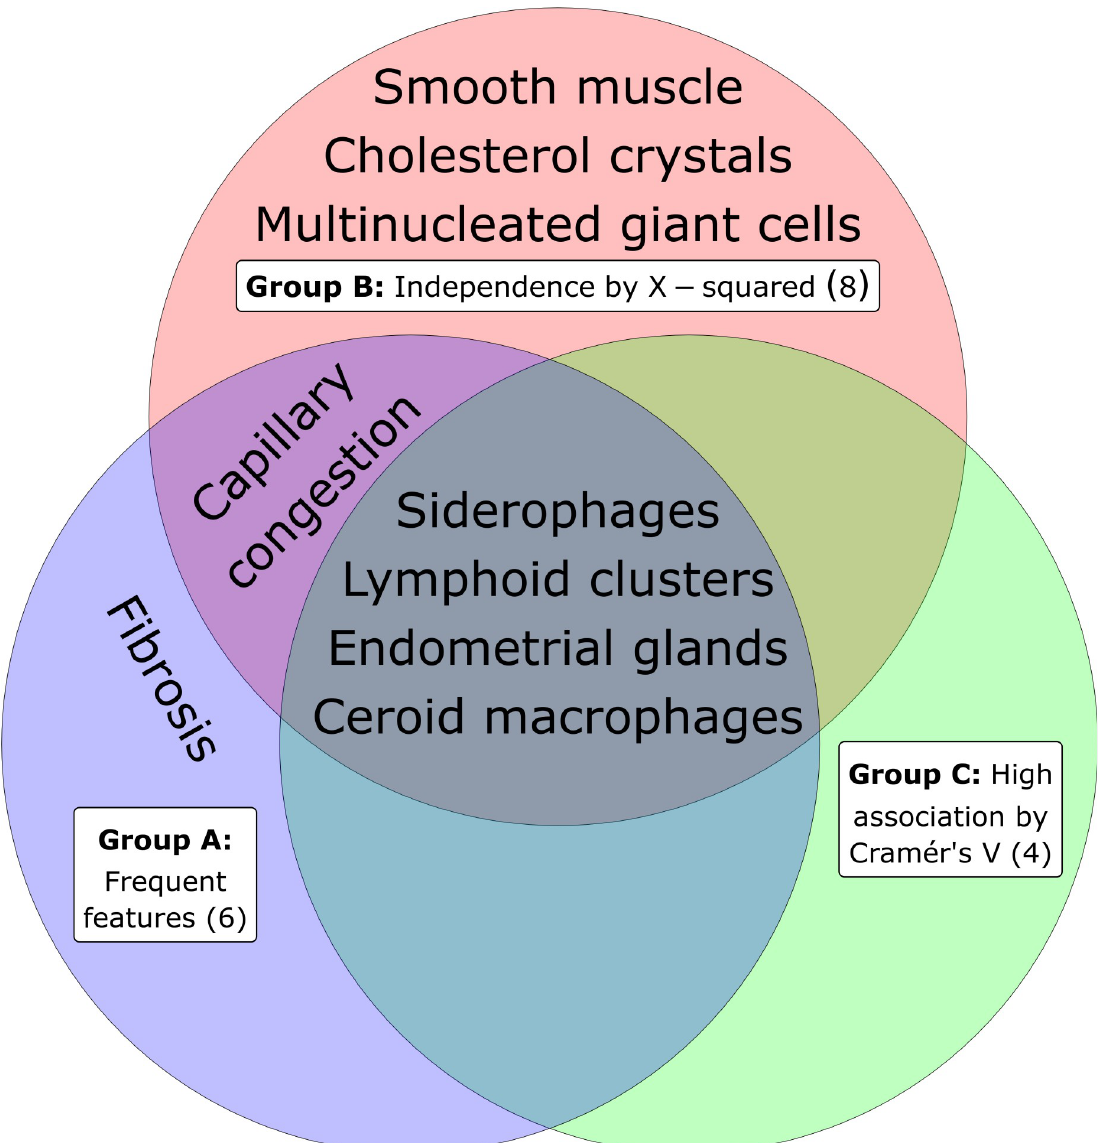
Fig 5. Venn plot showing the overlap of the 6 frequent features (Group A), the 8 features with significant association to disease by Chi-squared test (Group B), and the 4 features with high strength of association to disease by the Crame´r’s V coefficient (Group C).